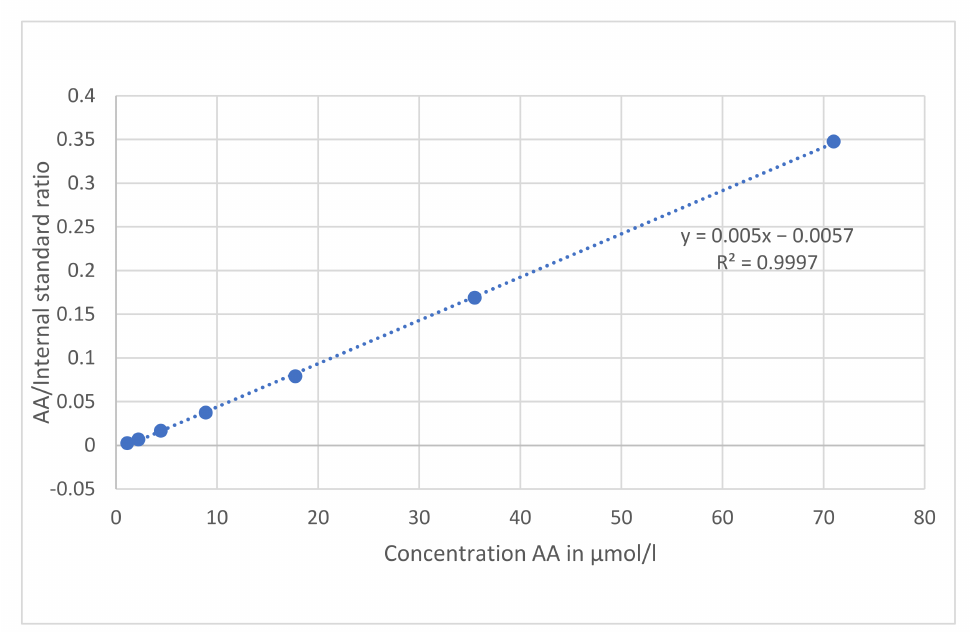
Figure 2. Example of a calibration